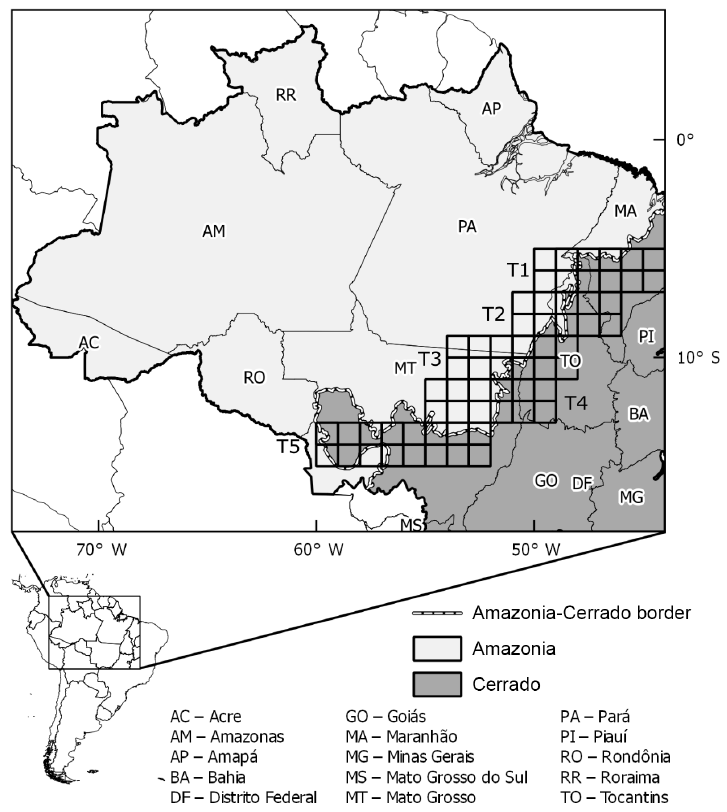
Figure 1. Delimitation of the study area, showing Amazonia (in light gray) and the Cerrado (in dark gray) (IBGE, 2004), and the location of five west–east transects used in this work (from T1 to T5). The dashed line represents the border between